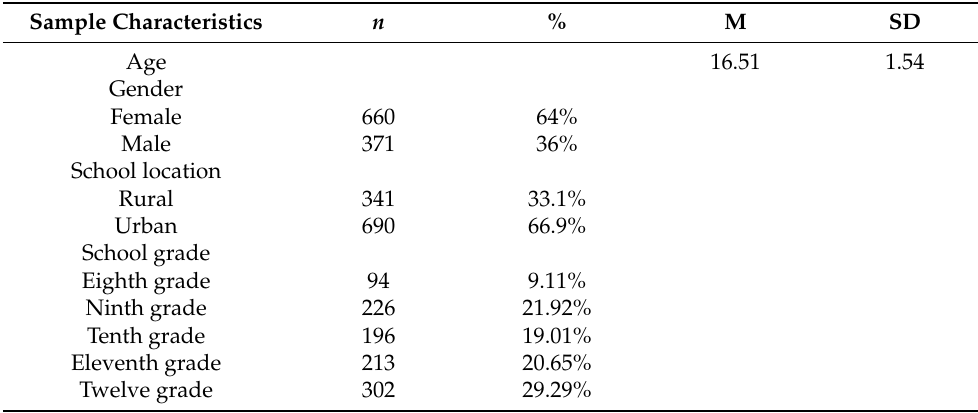
Table 1. Sample Demographic Characteristics. Sample